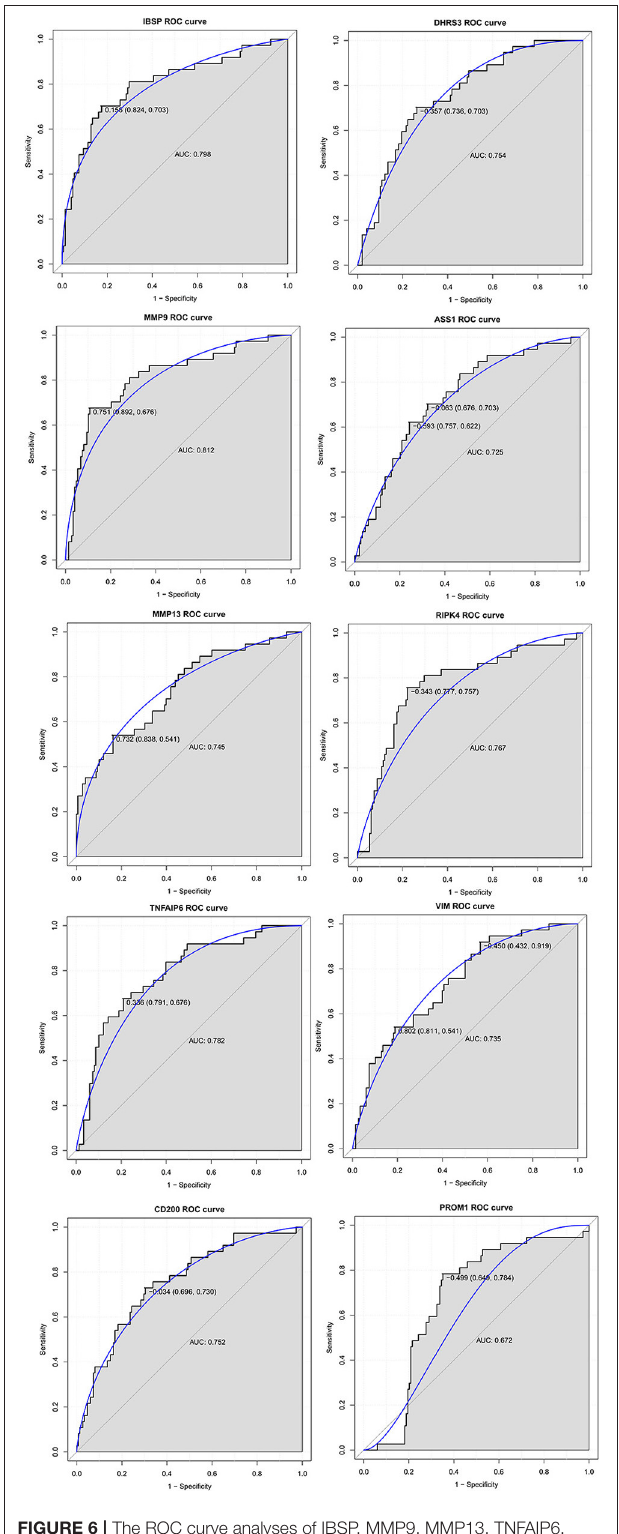
FIGURE 6 | The ROC curve analyses of IBSP, MMP9, MMP13, TNFAIP6, CD200, DHRS3, ASS1, RIPK4, VIM, and PROM1 in breast cancer bone metastasis. The x axis and y axis presented specificity and sensitivity,